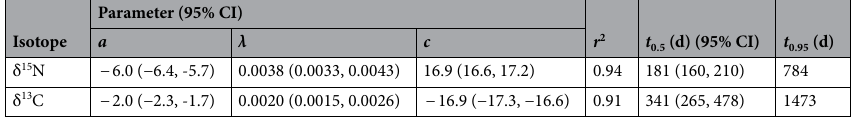
turnover dynamics were consistent with first-order exponential model predictions, with high exponential model fits across individual yellowtail ( r 2 range 0.97–0.99, mean 0.98 ± 0.1; Fig. 2a) and higher r 2 values for all individu- als than for the single model fit across all yellowtail ( r 2 = 0.94; Fig. 2b). Pooled yellowtail muscle δ 13 C values also increased consistently throughout the experiment (Fig. 3 and Table 2). δ 13 C values increased from 0–532 days, increasing from -19.0 ± 0.1‰ to − 17.6 ± 0.2‰ over this period (Fig. 3). Subsequent δ 13 C values were generally consistent, reaching − 17.5 ± 0.1‰ at 753 d. Model fits showed an asymptote at longer time periods than for δ 15 N both for individual yellowtail (Fig. 3a) and grouped data